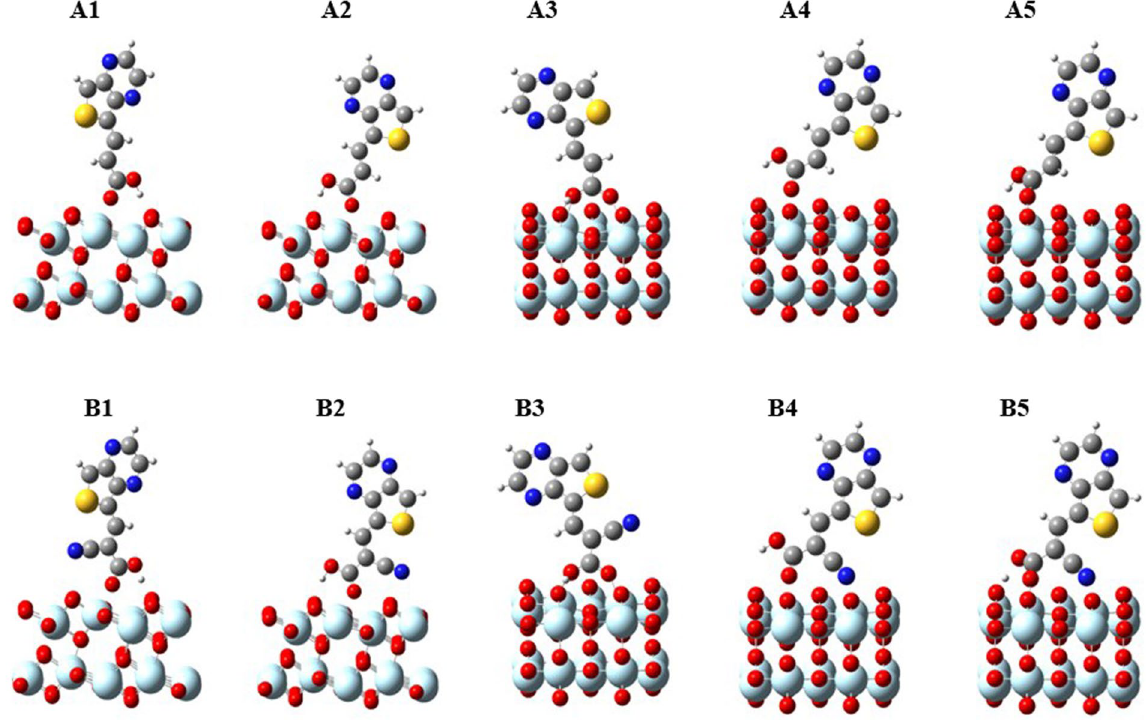
Figure 2. The optimized structures of most stable five adsorption configurations of model dyes (A and B) on TiO 2 .